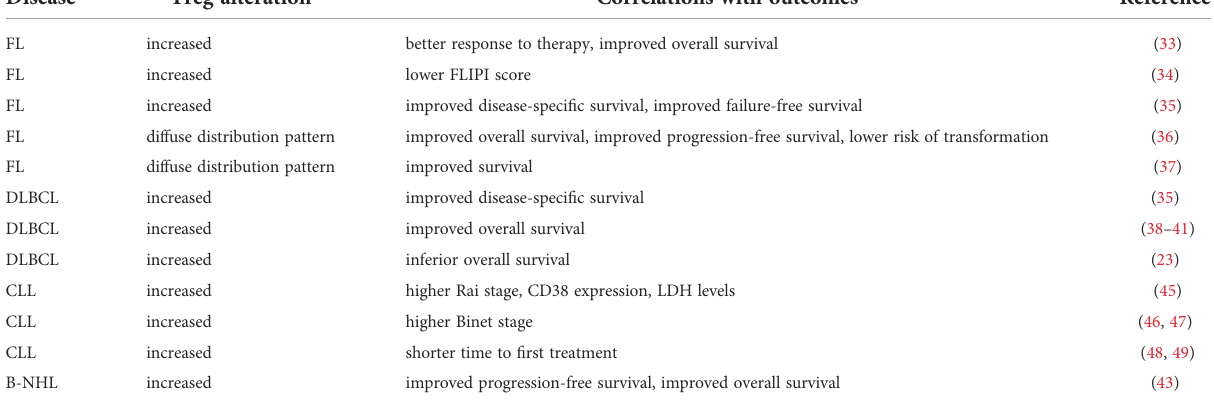
TABLE 1 Prognostic value of Tregs in patients with B-cell lymphoid malignancies. Disease Treg alteration Correlations with